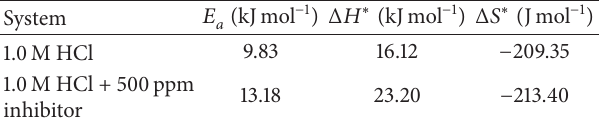
Table 5: Activation parameters of the dissolution reaction of zinc in 1.0M HCl in the absence and presence of 500ppm of marjoram extract. System